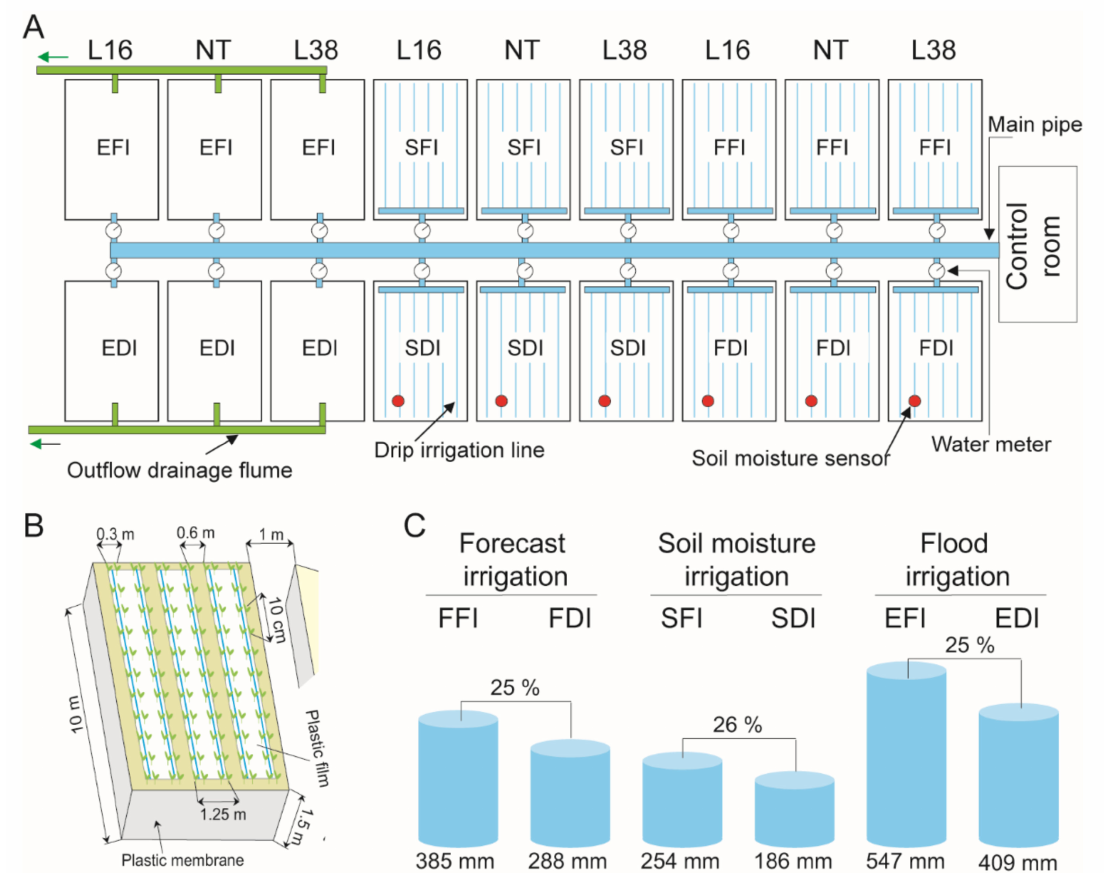
Figure 1. An illustration of differential irrigation experiments and applied different irrigation amounts in the field trial. ( A ) Layout of the experimental plots. ( B ) Illustration of field hole designs. The bottom of each hole was sealed with waterproof polyethylene film. ( C ) Full irrigation of forecast (FFI), soil moisture (SFI), and flood irrigation based on evapotranspiration estimates (EFI) models and were used to create their deficit irrigations as DFI, SDI, and EDI, respectively by delivering approximately 25% less water. Irrigation volume numbers depicted in the figure represent average numbers of treatments for three